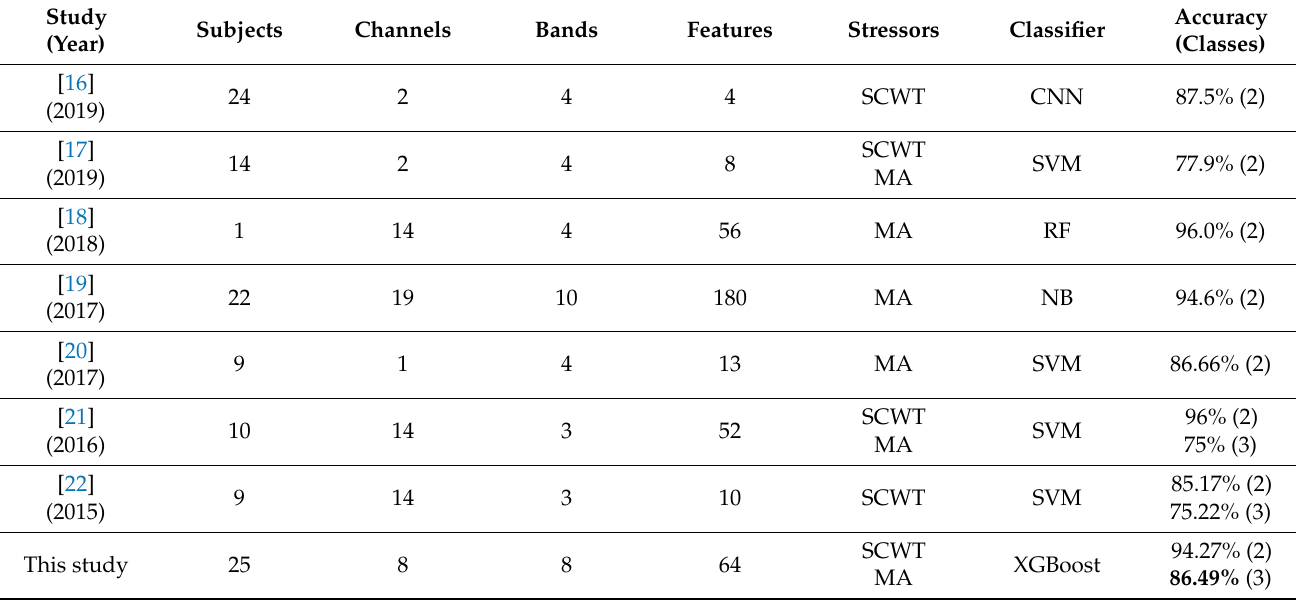
Table 7. A comparison of this study and past